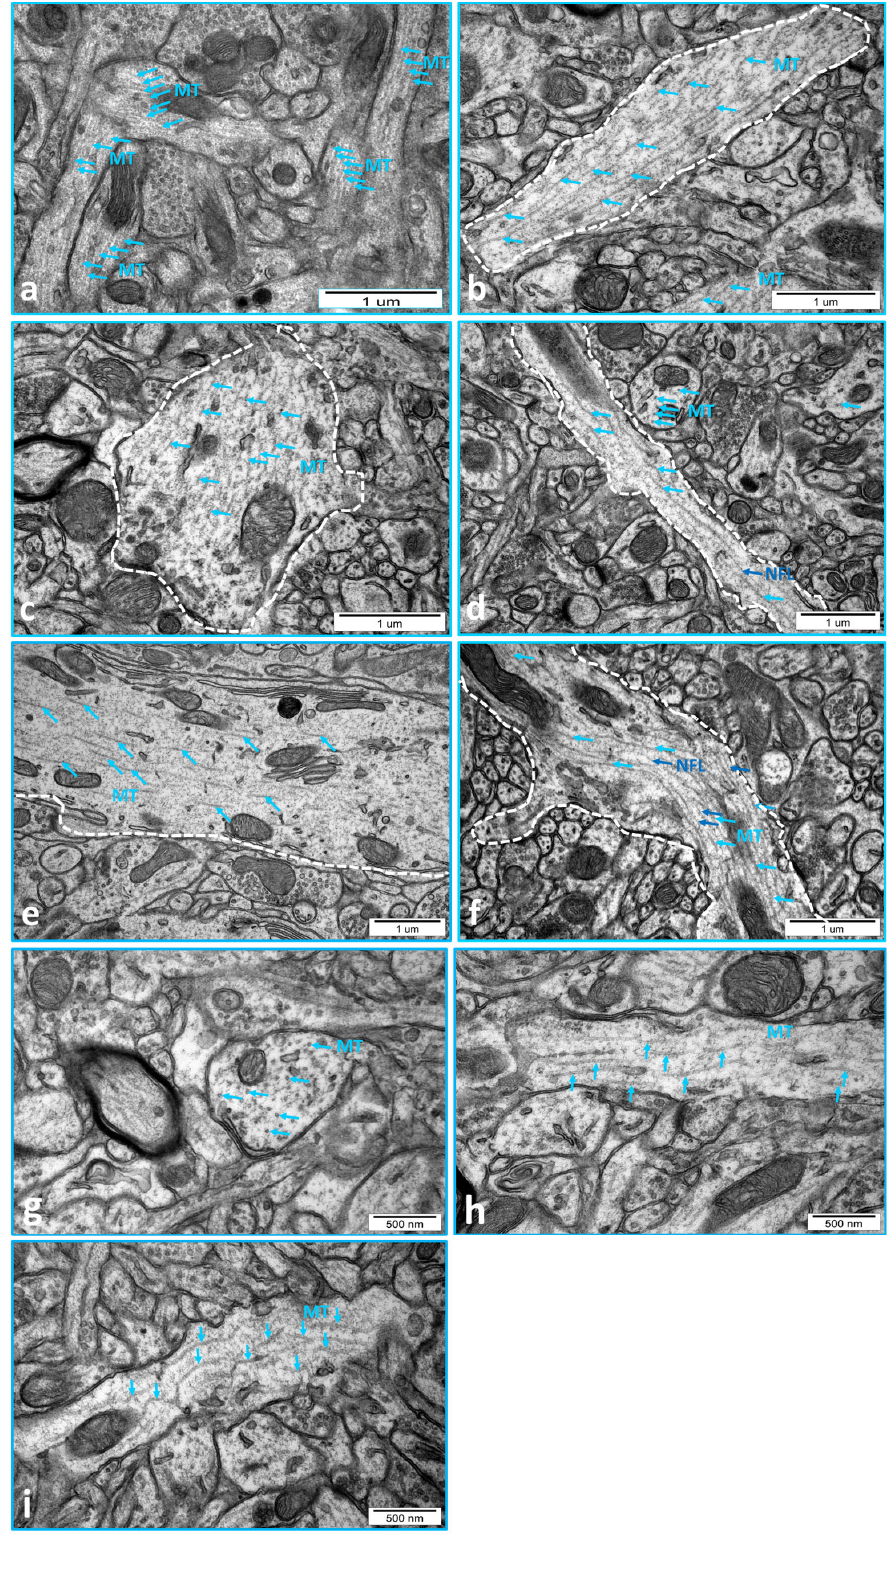
Figure 1. Panel I. The effect of Tsc2 haploinsufficiency on the ultrastructure of neuronal cells in the hippocampus (CA1/CA2 region) ( a , b ), cerebral cortex ( c , d ), and cerebellum ( e , f ). Control